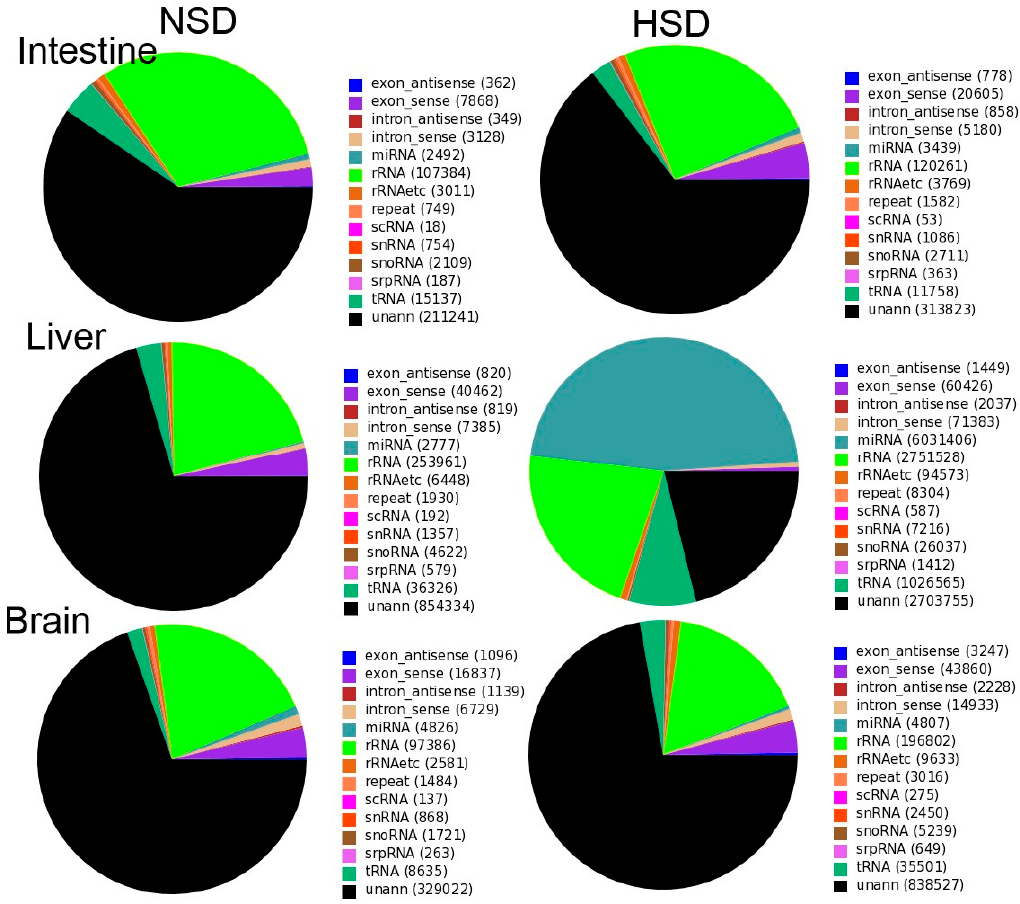
Figure 1. Annotation of total small RNAs derived from Illumina sequencing of Megalobrama amblycephala all RNAs libraries. (NSD: the fishes fed with 34% level starch, HSD: the fish fed with 51% level starch).